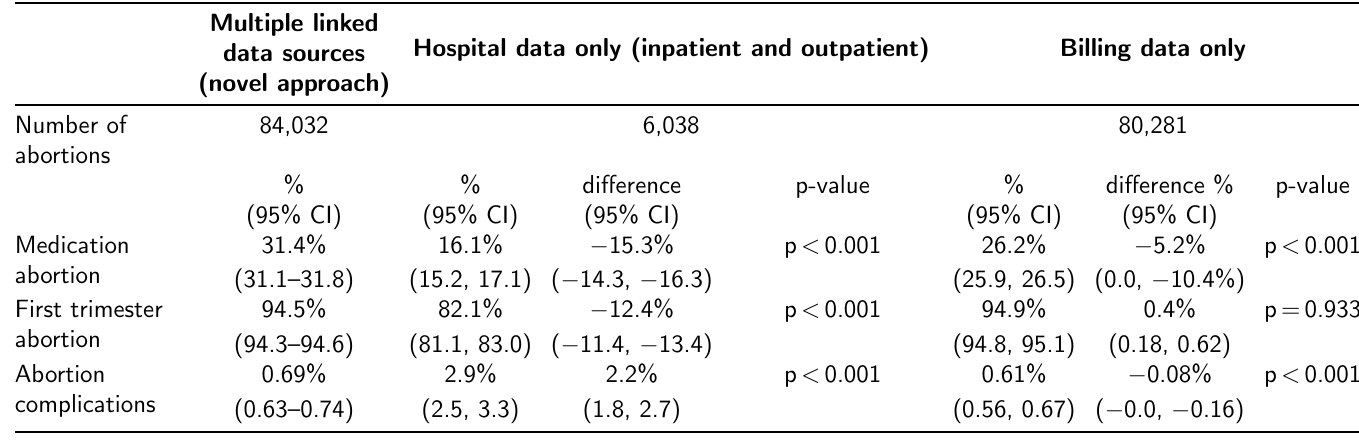
Table 2: Impact of using multiple data sources vs. single data sources (Principle 2) to define abortion cohorts on the number and characteristics of abortions identified